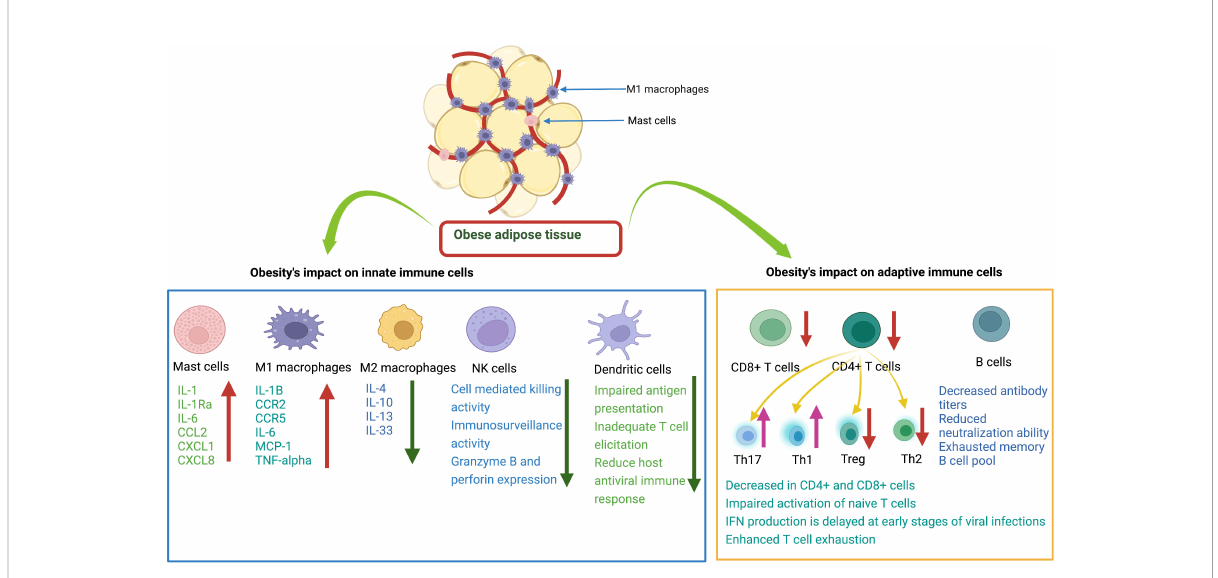
FIGURE 2 Effects of obesity on innate and adaptive immune cells. Mast cells (MCs) release various cytokines and chemokines that promote in fl ammation. M1 macrophages release proin fl ammatory mediators. M2 macrophages release anti-in fl ammatory cytokines. Natural killer cells decrease immune surveillance activity. Dendritic cells have impaired ability to present antigens to other immune cells. CD8+ T cells have decreased cytotoxic activity to kill infected cells. CD4+ T cells: there is a decrease in Treg and Th2 cells and an increase in Th17 and Th1 cells. B cells have decreased antibody production with reduced neutralizing